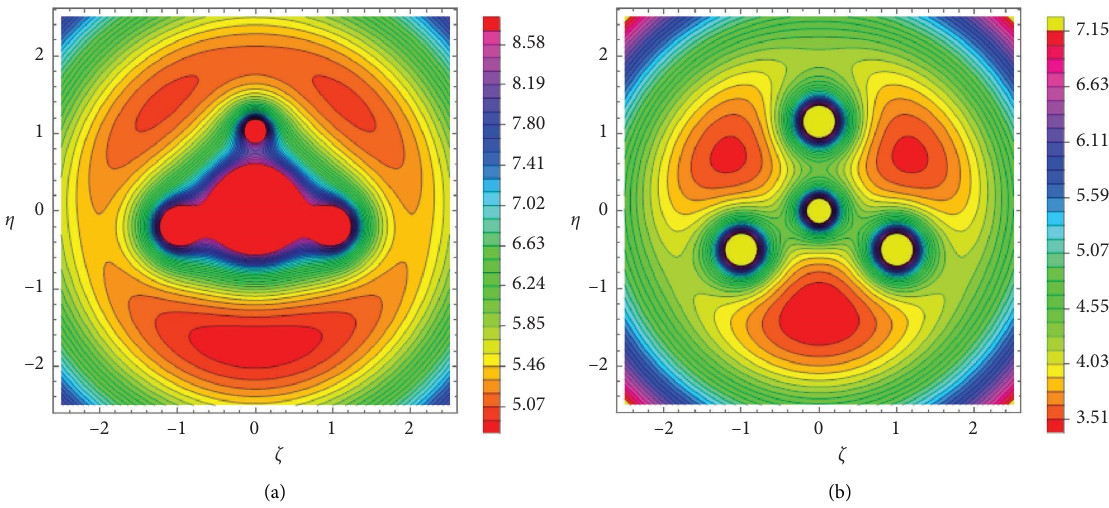
Figure 5: Case I: the evolution of zero velocity curves. (a) μ